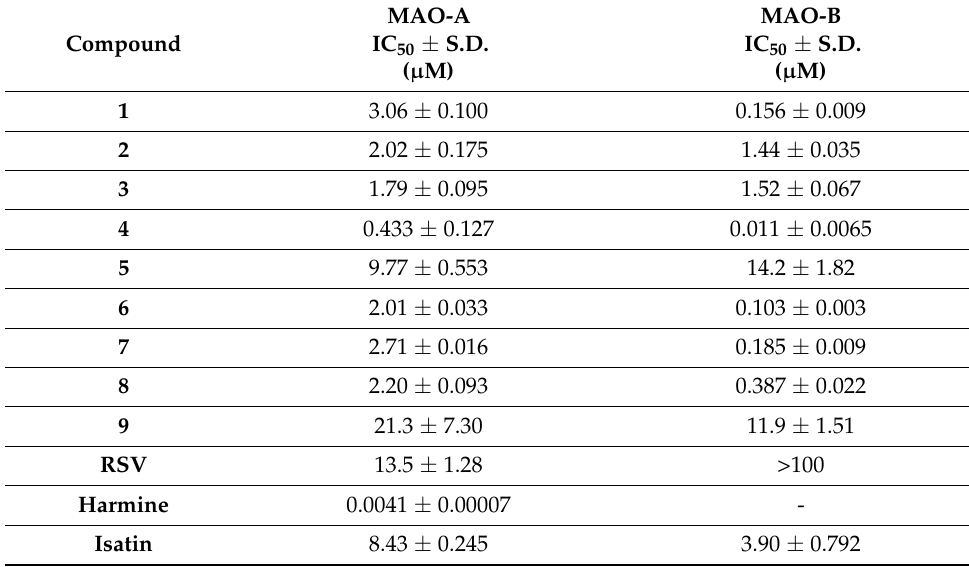
Table 1. The MAO inhibitory activities * of compounds 1–9 and